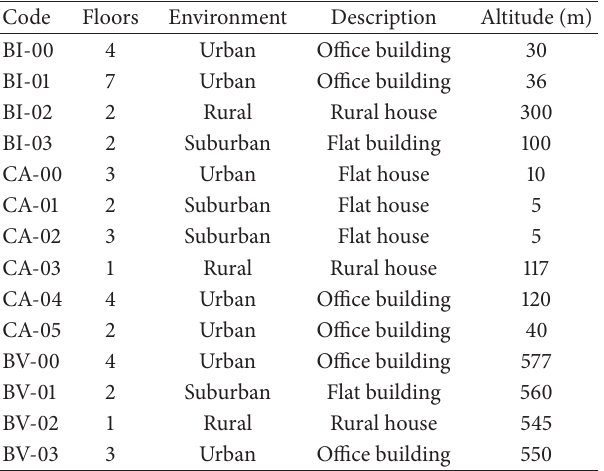
Table 1: Characteristics of the measurement sites. Code